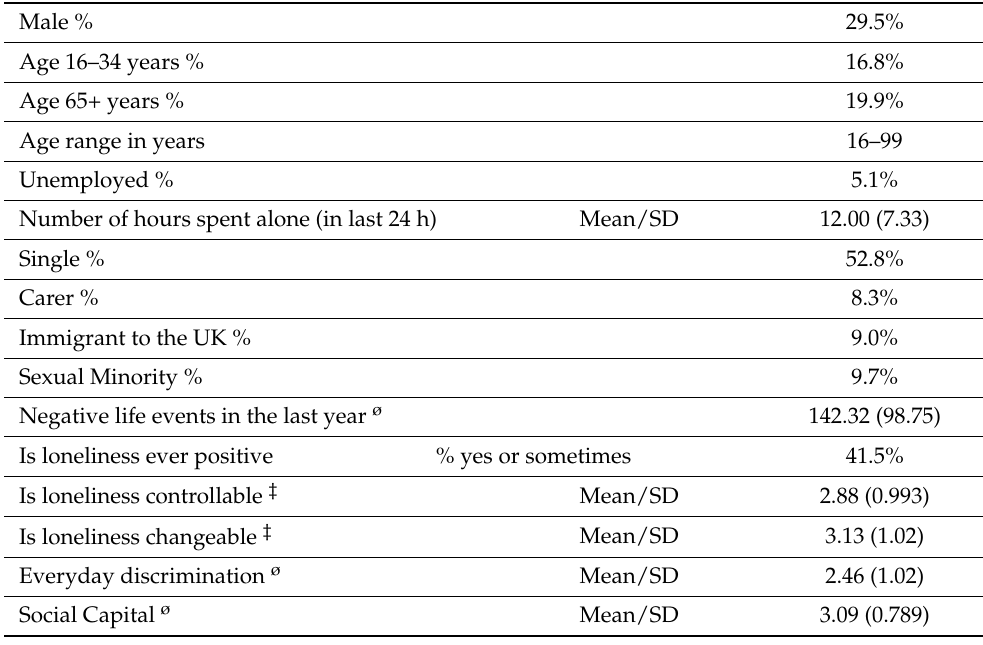
Table 1. Characteristics of final sample used in the current